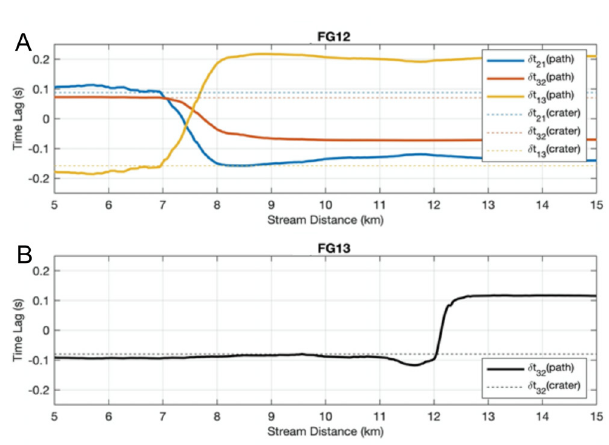
Figure 5: Expected time delays between channels at each station from a sound source from the crater, such as an eruption (dashed lines), and a sound source from the adjacent Las Lajas drainage (solid lines). Ambigu- ity exists at Station FG13 at values close to ´ 0 . 1 s be- tween 11 and 11.5 km stream distance where time lag differences actually increase.